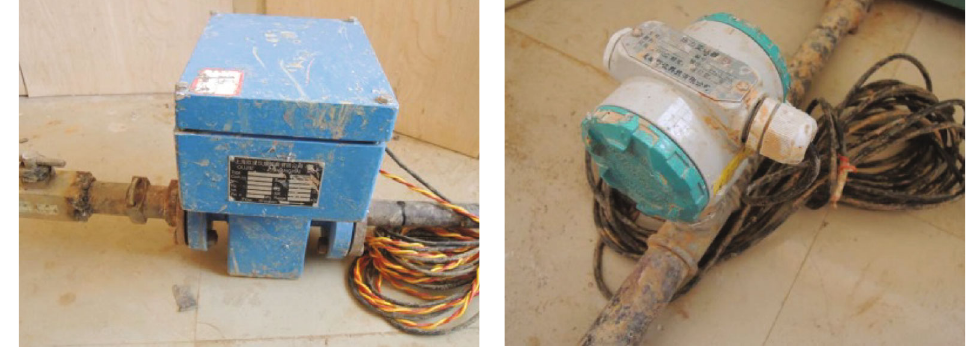
Figure 3: Grouting data recorder.